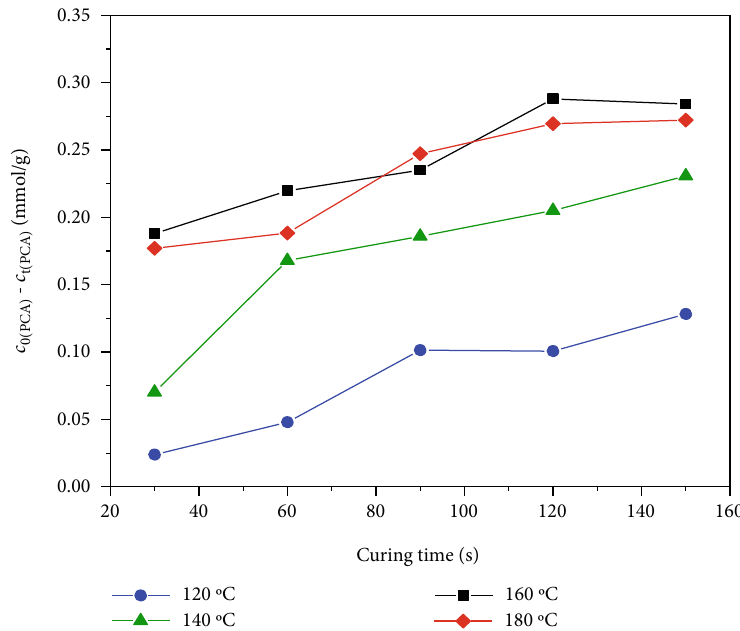
Figure 1: E ff ect of curing time on the consumption of carboxylic acids in the BTCA fi nishing system.